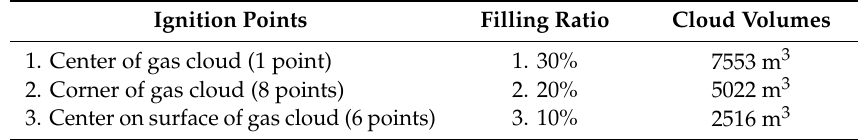
Table 5. Blowout and explosion scenarios below the drill